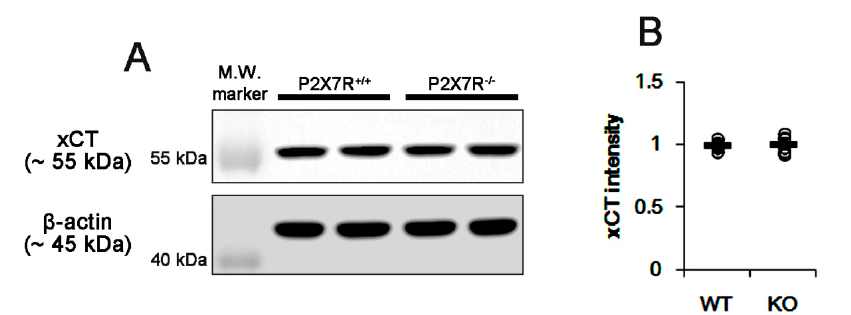
Figure 4. Effects of P2X7R deletion on xCT expression. P2X7R deletion does not affect xCT expression. ( A ) Representative Western blots of xCT expression. ( B ) Quantification of xCT level based on Western blot data. Open circles indicate each individual value. Horizontal bars indicate mean value (mean ± S.E.M.; * p < 0.05 vs. WT animals; n = 7, respectively).